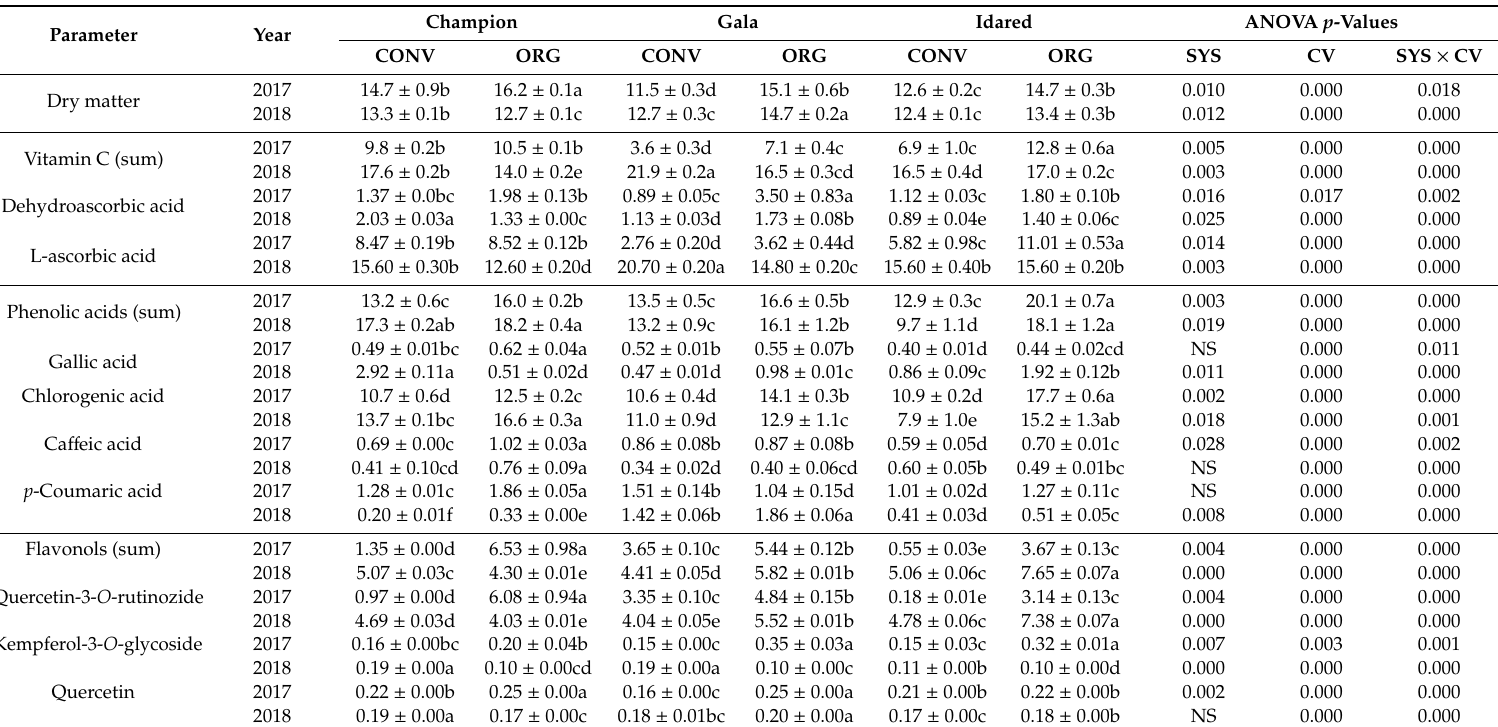
Table 4. E ff ect of (and interaction between) production system (conventional and organic) and cultivar (Champion, Gala, Idared) on the dry matter content (g / 100 g f.w.), vitamin C (mg / 100g f.w.), phenolic acids (mg / 100g f.w.), and flavonols (mg / 100 g f.w.) concentrations (mean ± SD) in apple fruit (2017–2018). Within rows, mean values followed by the same letter are not significantly di ff erent at p <